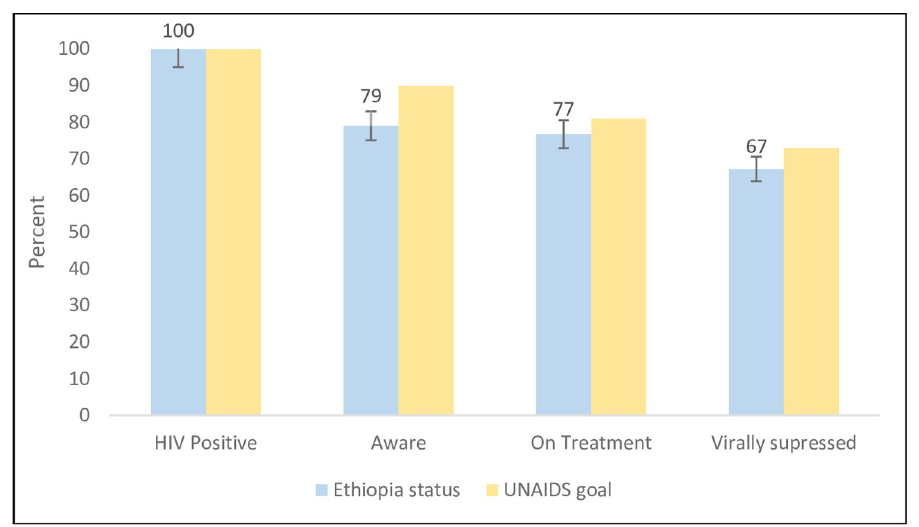
Fig 2. Achievements of unconditional UNAIDS 90-90-90 targets among participants aged 15–64 years in urban Ethiopia, Ethiopia population-based HIV impact assessment, 2017–2018 (n = 609).